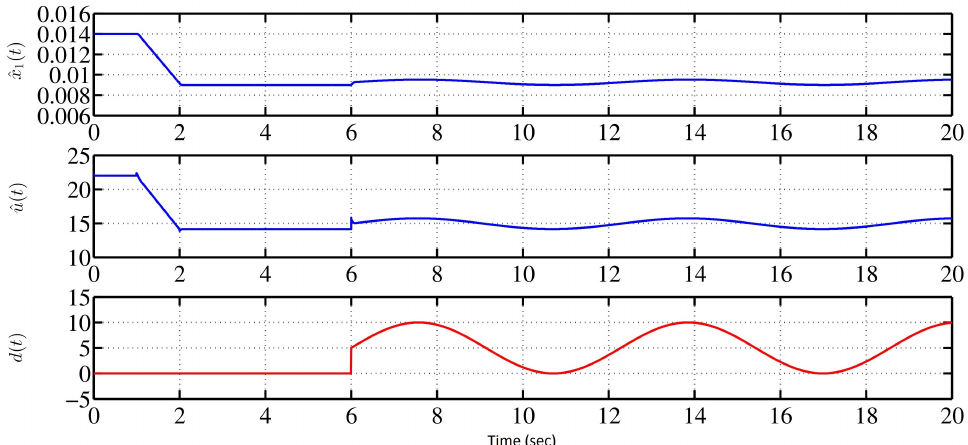
Figure 5. Response of reference model driven by the stabilizer in the presence of sinusoidal pay- load